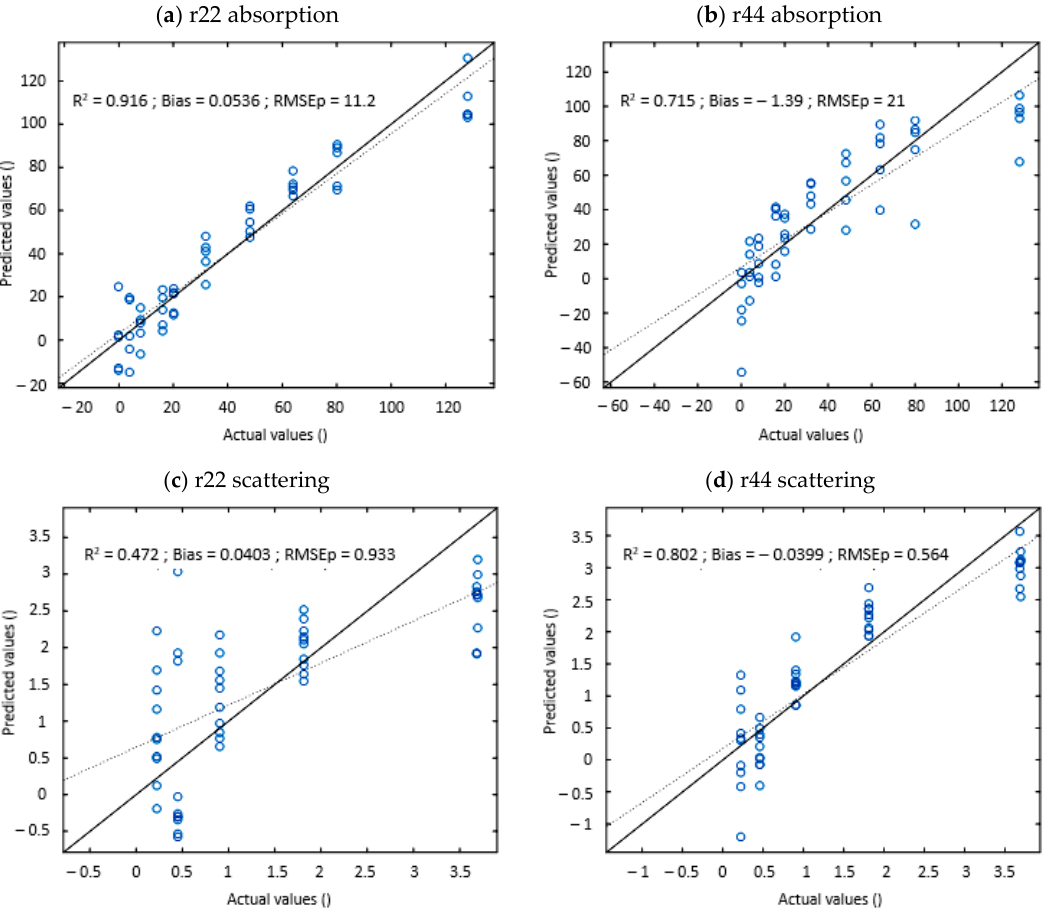
Figure 5. Predicted vs measured absorber concentrations (c abs ) for ( a ) r 22 and ( b ) r 44 , and scatterer concentrations (c dif ) for ( c ) r 22 and ( d ) r 44 .